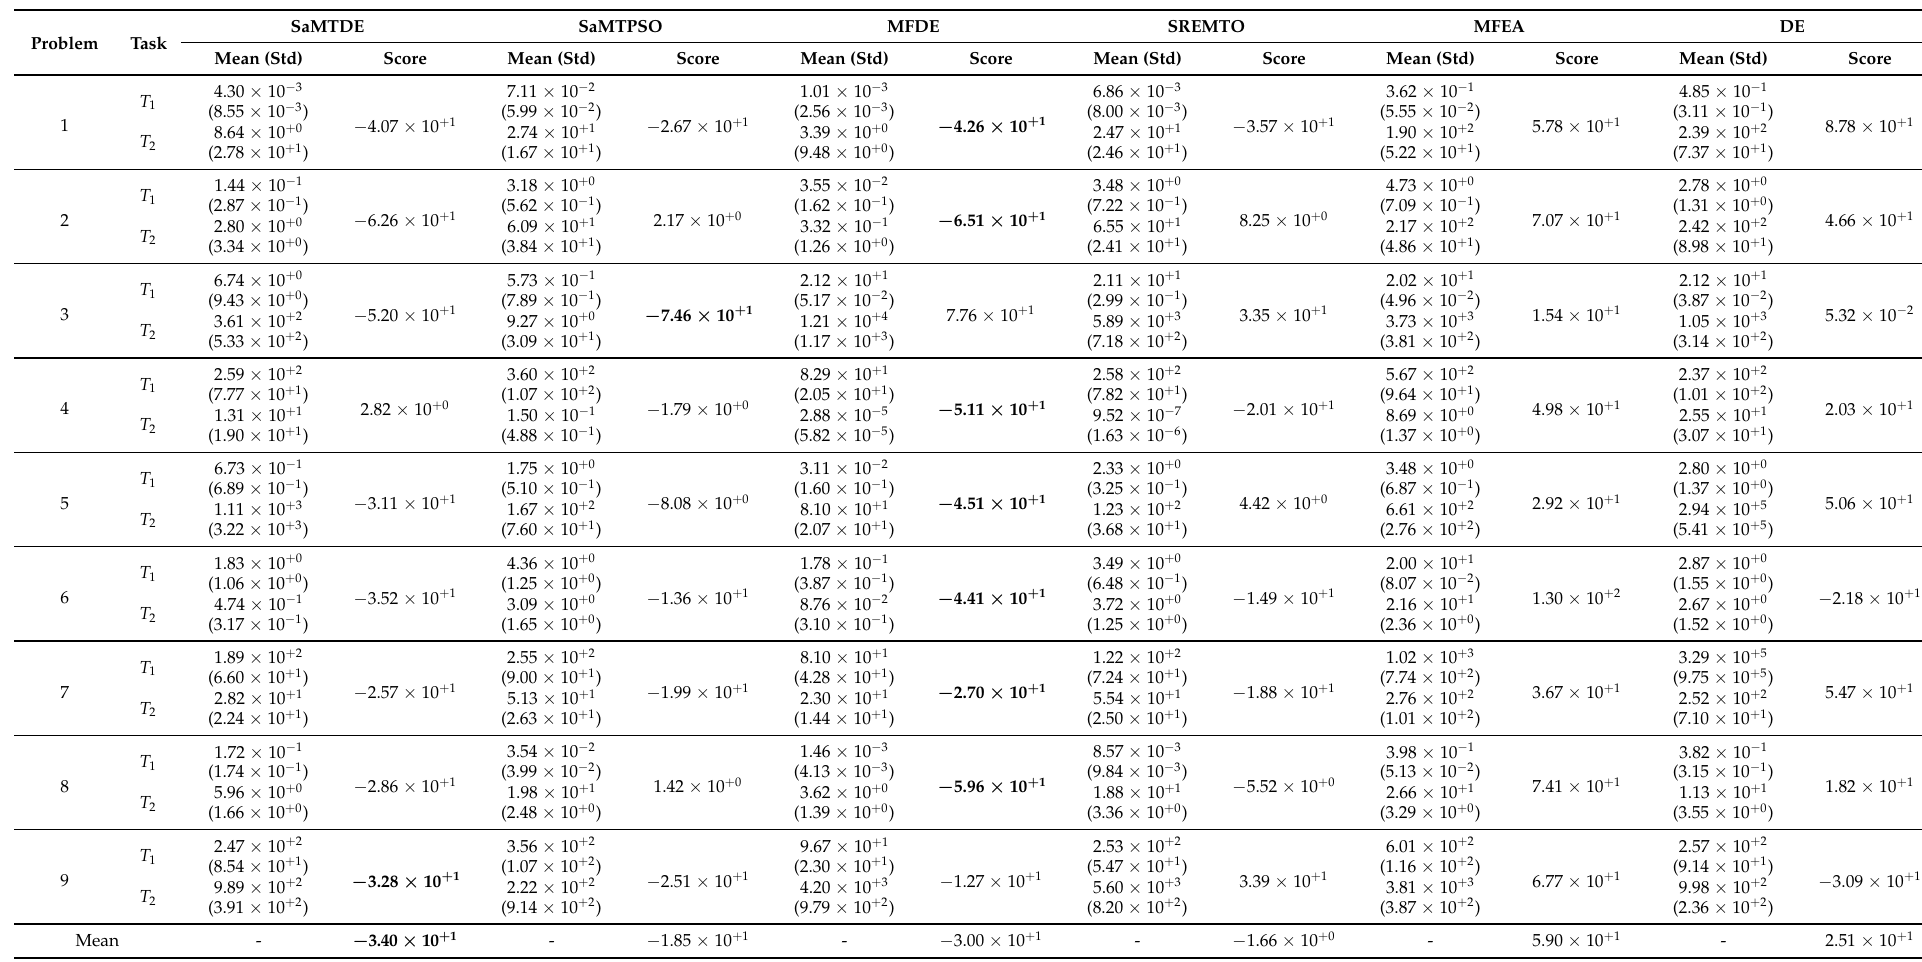
Table 4. Achieved FVs (mean, bracketed standard deviation) of the SaMTDE, the SaMTPSO, the MFDE, the SREMTO, the MFEA and the DE. The best results are shown in bold.